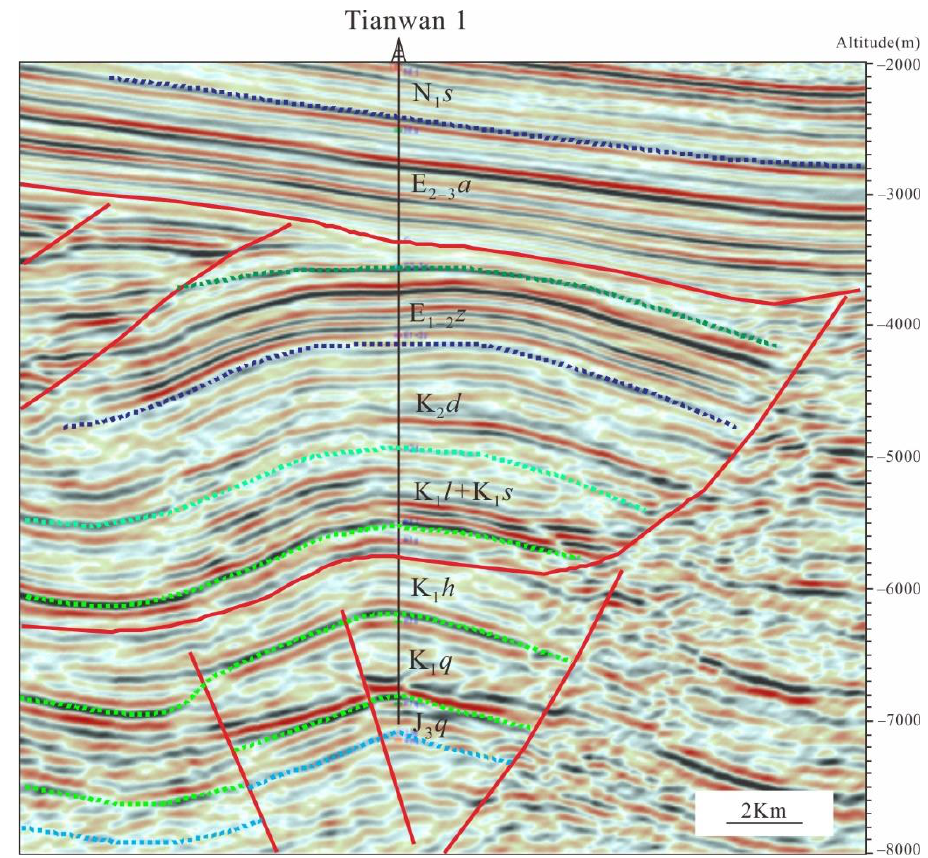
Figure 4. Tectonic style section of Dongwan